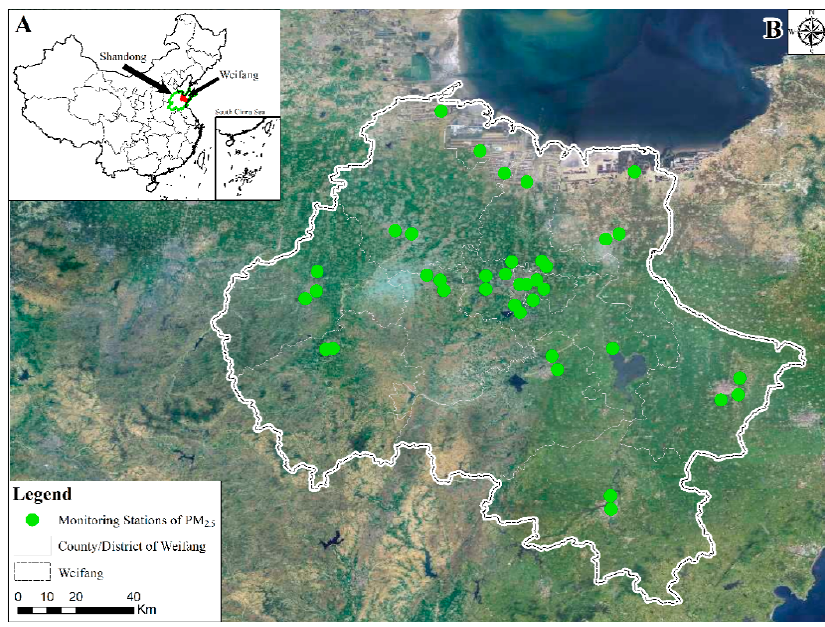
Figure 1. Study area and spatial distribution of monitoring sites.